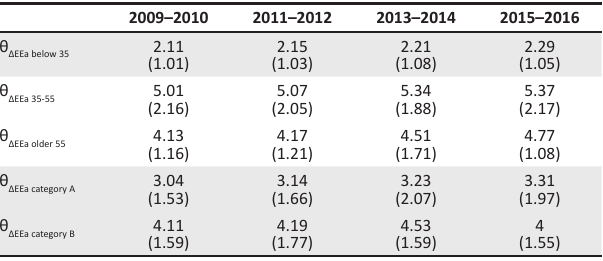
FIGURE 6: Summary of panel data estimations: Employee effort of new technology.